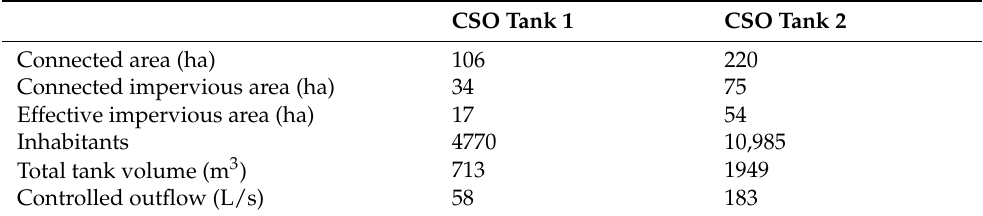
Table 1. Catchment and combined sewer overflow (CSO) tank characteristics.